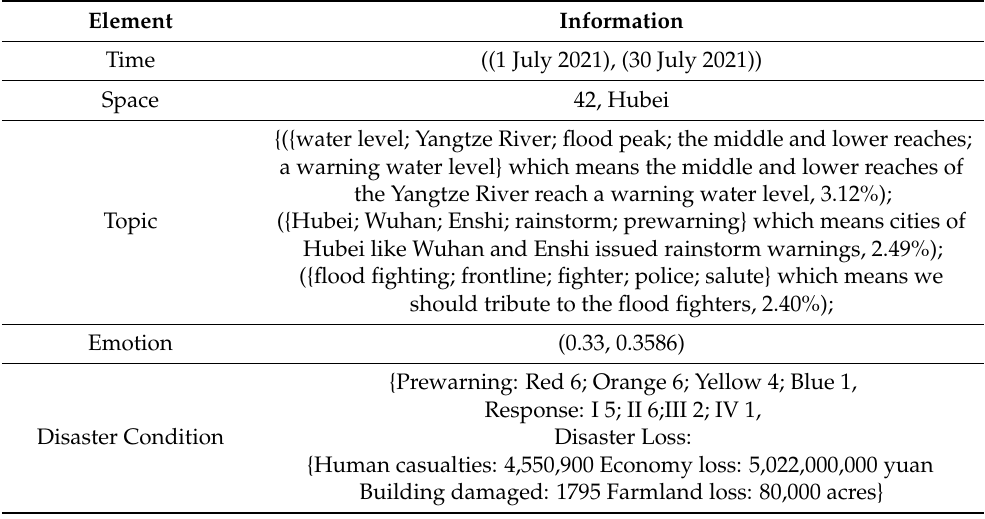
Table A1. Element information of Hubei Province object entity.